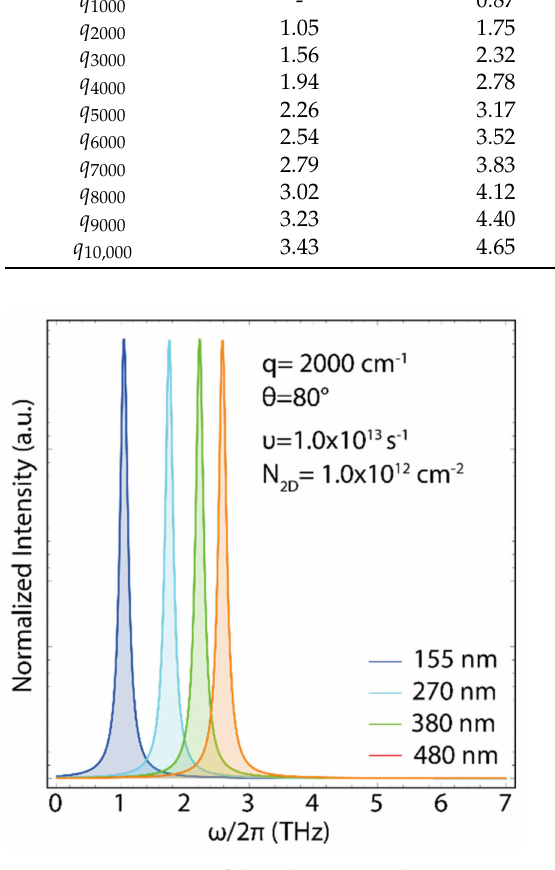
Figure 6. Maximum of the plasmon peak ( ≤ 7 THz) at q = 2000 cm − 1 and θ = 80. Table 5. Percentage variation in plasmon frequency by increasing ribbon width for selected momenta and at θ =